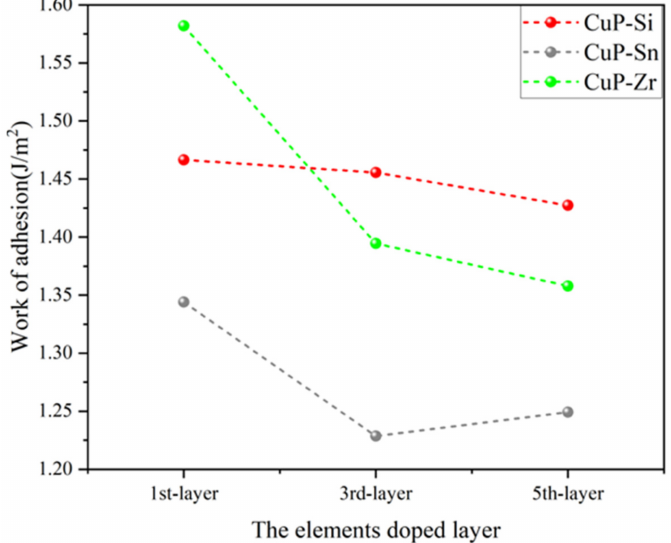
Figure 7. The work of adhesion ( W ad ) of the elements (Si, Sn, and Zr) doped at different layers in CuP/Cu interface structure.